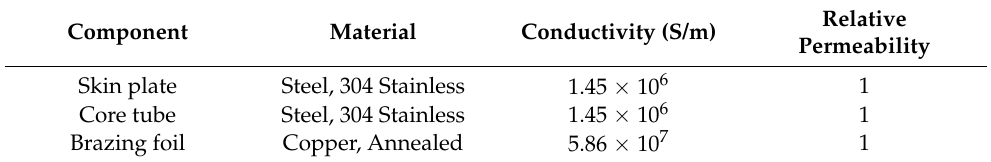
Table 1. Electromagnetic properties of the specimen components.